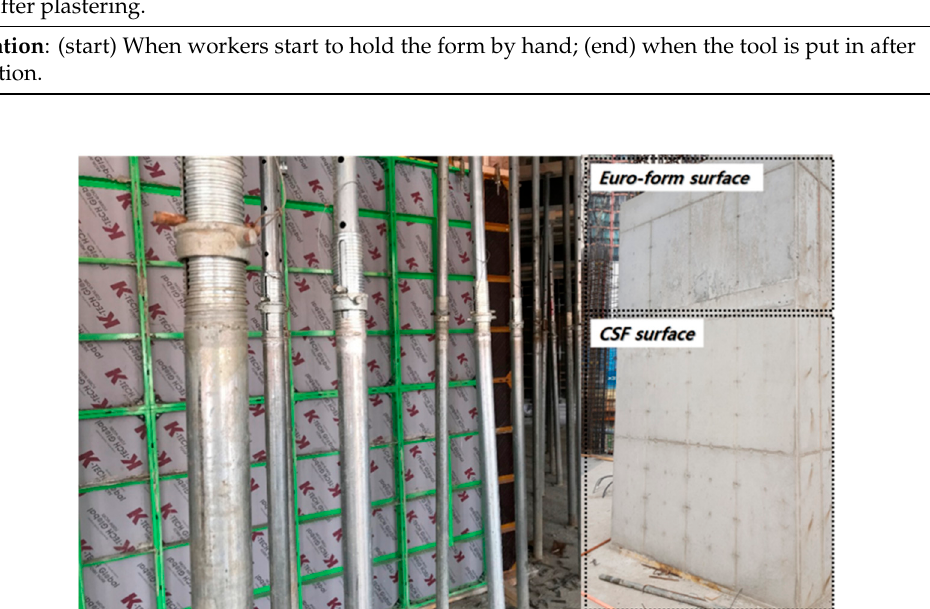
Figure 12. Concrete surface quality comparison between the CSF and the Euro form. Table 9. Performance comparison between CSF and Al-form.